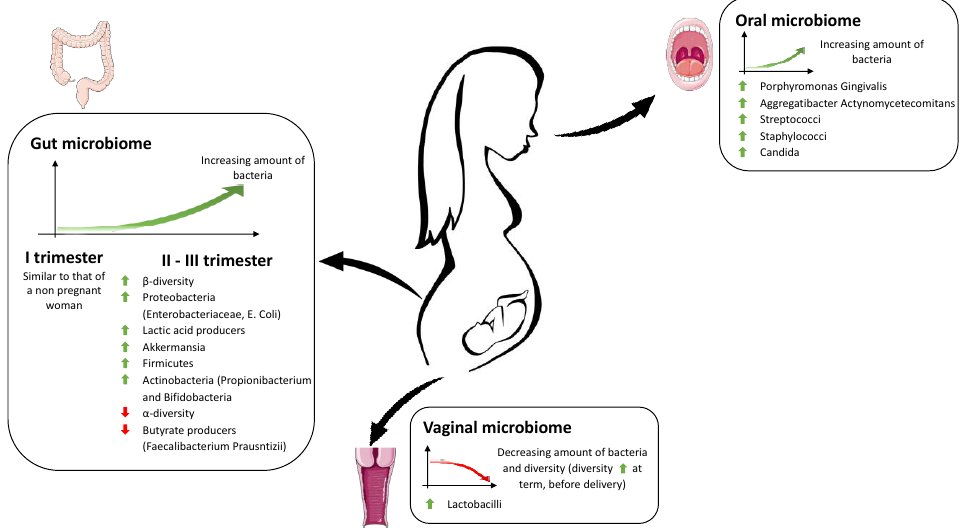
Figure 1. Schematic representation of the main physiological changes in the maternal microbiome during pregnancy. The Figure was partly generated using Servier Medical Art, provided by Servier, licensed under a Creative Commons Attribution 3.0.